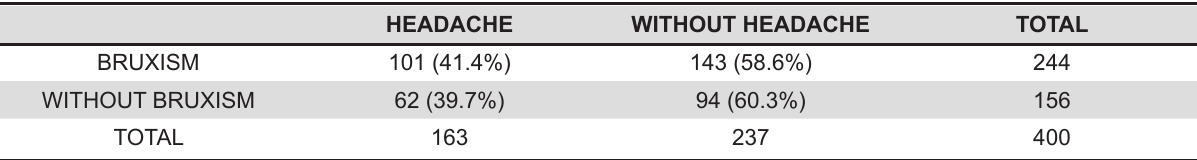
p=0.743, OR=1.07